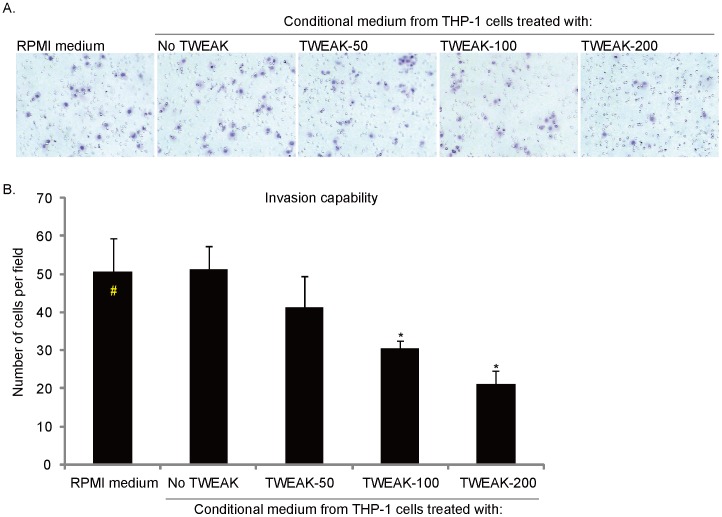
Conditioned media from TWEAK-treated THP-1 macrophages inhibits HO-8910PM cell in-vitro invasion.HO-8910PM cells were either cultured in RPMI (group “#”) or in conditional medium from TWEAK (different concentration)-treated THP-1 cells for 24 hours, in-vitro cell invasion was measured by Matrigel invasion assay, and reprehensive images was shown in (A) (1∶200), the total number of cells which migrated through the Matrigel-coated membrane in each microcopy field was recorded (B). *p<0.05 vs. group “#” (B).